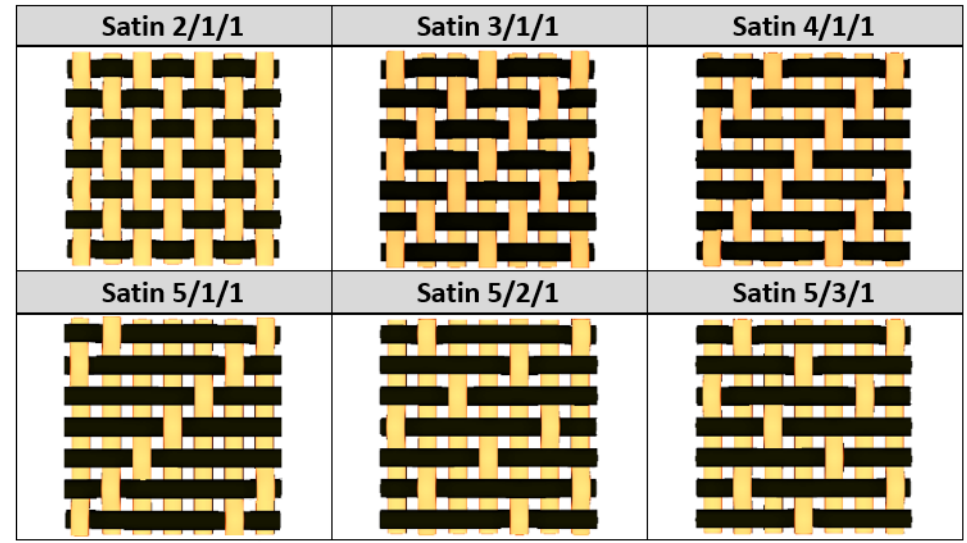
Figure 4. Types of fabrics utilized as composite reinforcement.